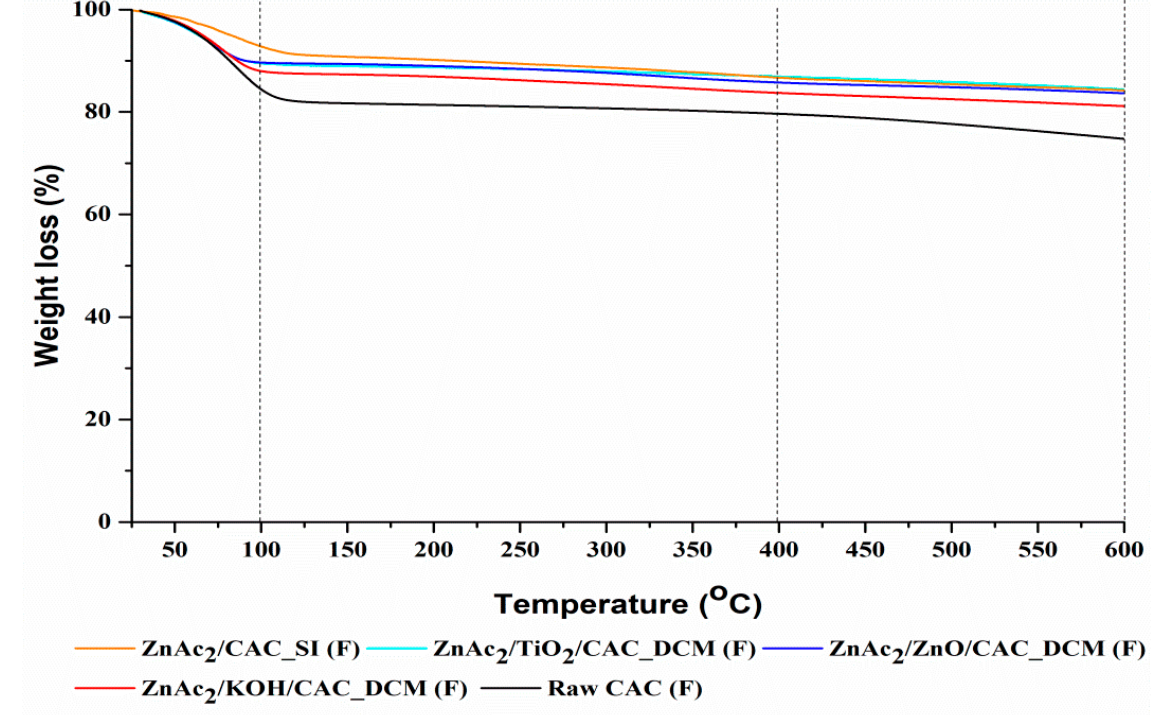
Figure 5. TGA profile analysis for fresh DCM/CAC, SI/CAC, and raw CAC adsorbents. Generally, the reduction in the mass percentage for the temperature derivative in phase (i) was associated with a reduction in the moisture content of the adsorbents [62].